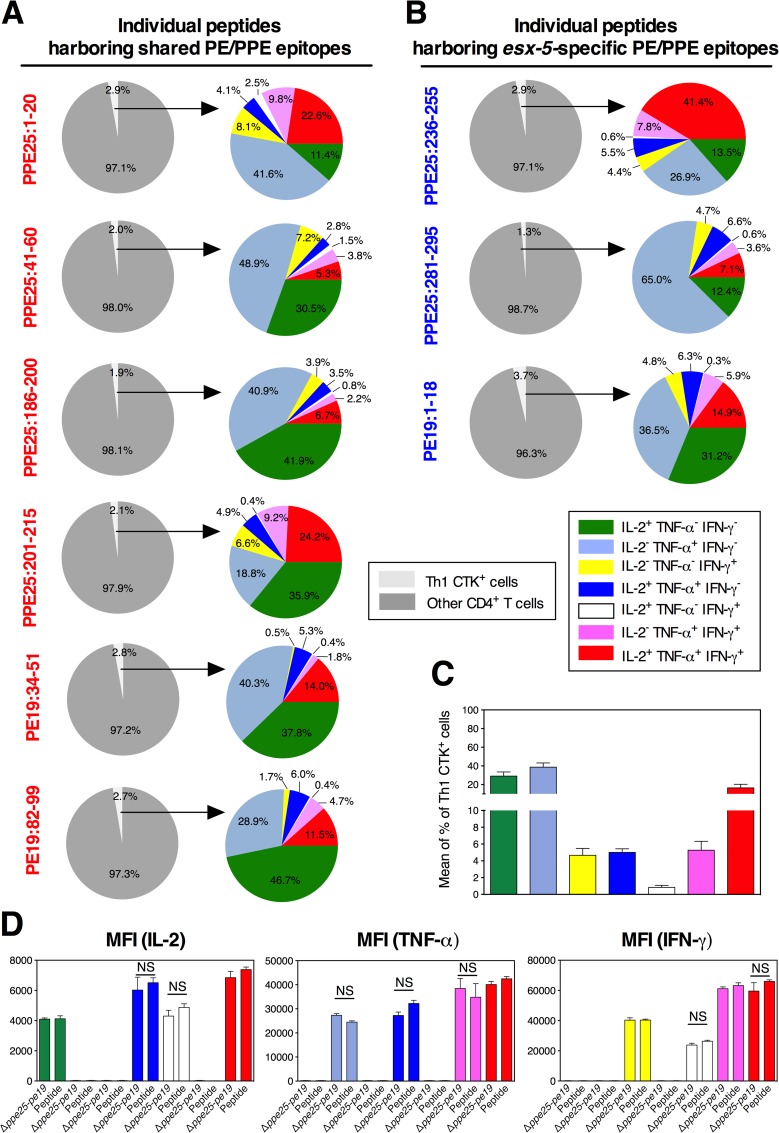
Th1 effector subsets specific to PE/PPE epitopes subsequent to vaccination with individual synthetic peptides.Percentage and composition of CD4+ T splenic effectors of C57BL/6 mice (n = 3 per group) vaccinated with individual synthetic peptides containing PE19- and PPE25-derived epitopes, either highly specific to esx-5 (A) or shared by other PE/PPE proteins (B) coded outside esx-5 region. C) Means ± SD of the frequencies of each Th1 subset, as cumulated for all the studied peptides, in the immunized groups. (D) The geometric Mean Fluorescence Intensities (MFI) of intracellular IL-2, TNF-α or IFN-γ in each of the antigen-specific functional Th1 subsets, as determined in the spleen of mice immunized with Mtb Δppe25-pe19 or with PPE25:1–20, as a representative peptide. The results are representative of two independent experiments.